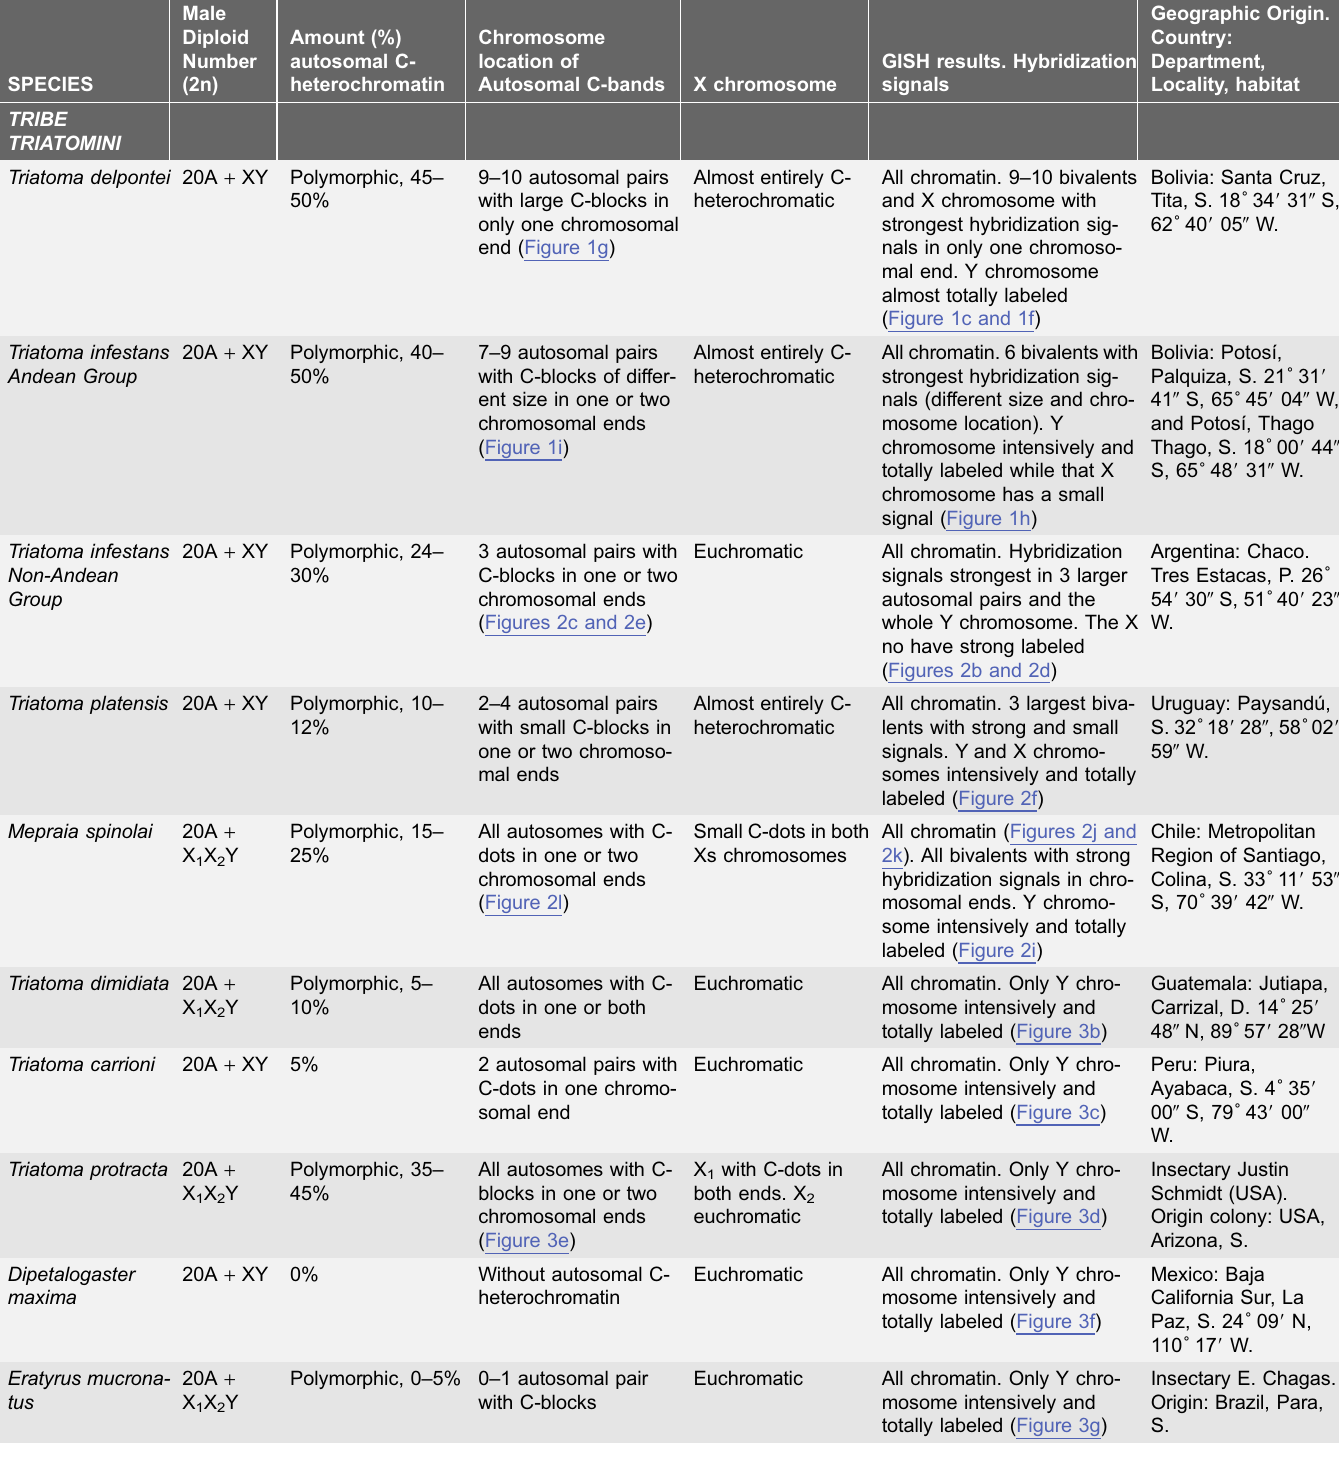
Table 1. Geographic origin, relevant cytogenetic traits and GISH results of the eleven Triatominae species analyzed by three genomic